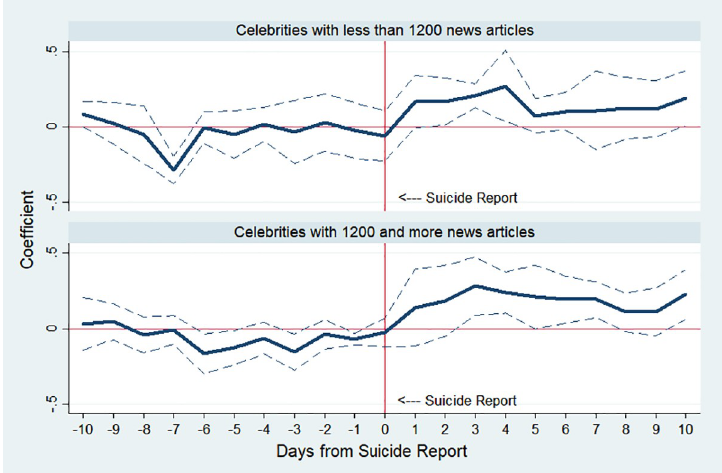
Fig 8. Estimated changes in total suicides before and after celebrity suicide media reports using the number of online news articles. Note: The top panel shows results using celebrity suicide reports of less than 1200 news articles and the bottom panel reports results using celebrity suicide reports with 1200 or more news articles. The number 1,200 was selected to divide the celebrities into two groups with enough and even sample sizes. There are seven cases of more than 1,200 news reports and six cases of lower than 1,200. The y -axis indicates an approximate percent change in public suicide by corresponding day, which is the estimated β in Eq (1). The dotted lines indicate 95% confidence k